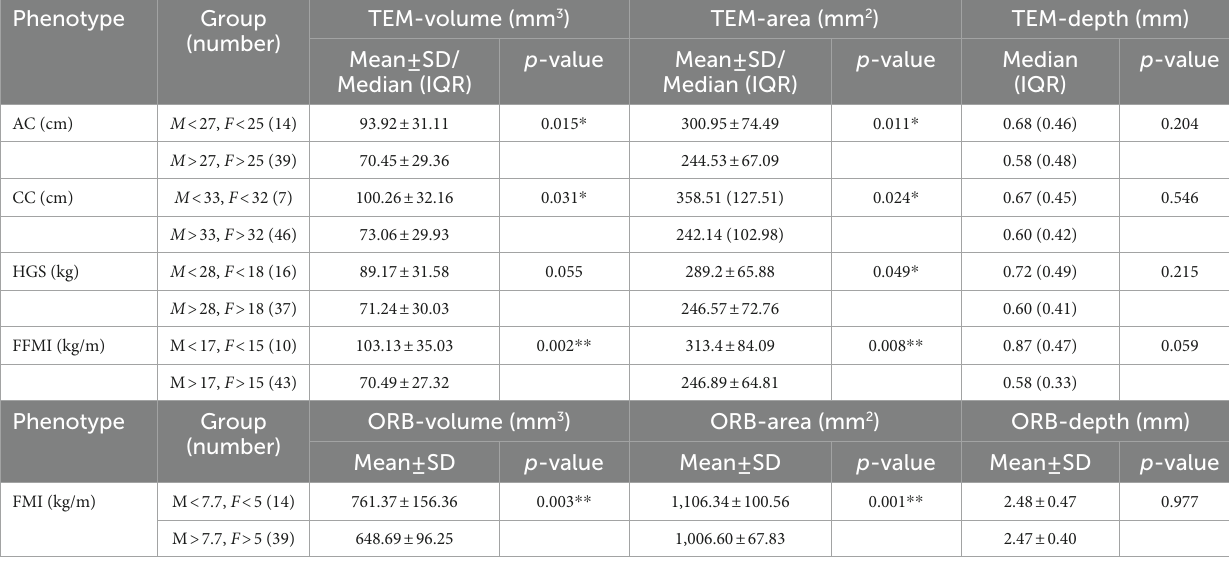
TABLE 3 Depression index differences among various malnutrition phenotype